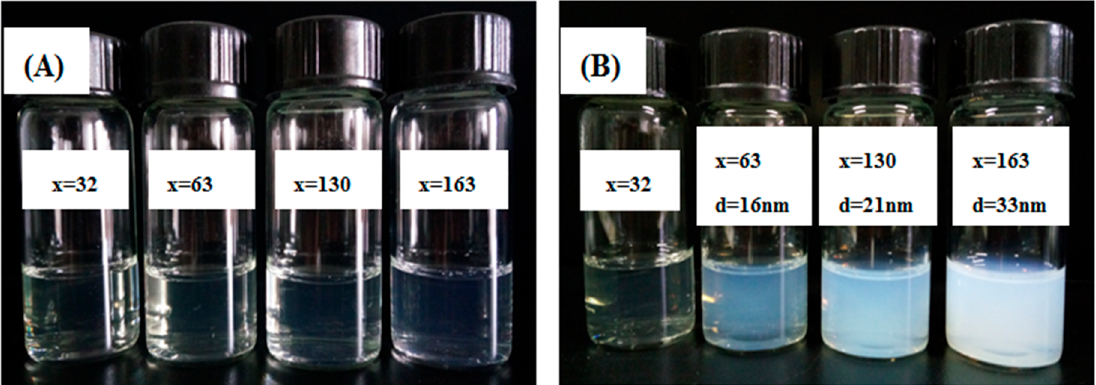
Figure 3. ( A ) Optical photographs of P(DMA 33 - b -NIPAM x )-S-(C=S)-S-C 12 H 25 (x = 32, 63, 130, 163) aqueous solution with 2.0 wt % concentration at 25 °C; ( B ) Optical photographs at 40 °C and diameter measured by dynamic light scattering (DLS).